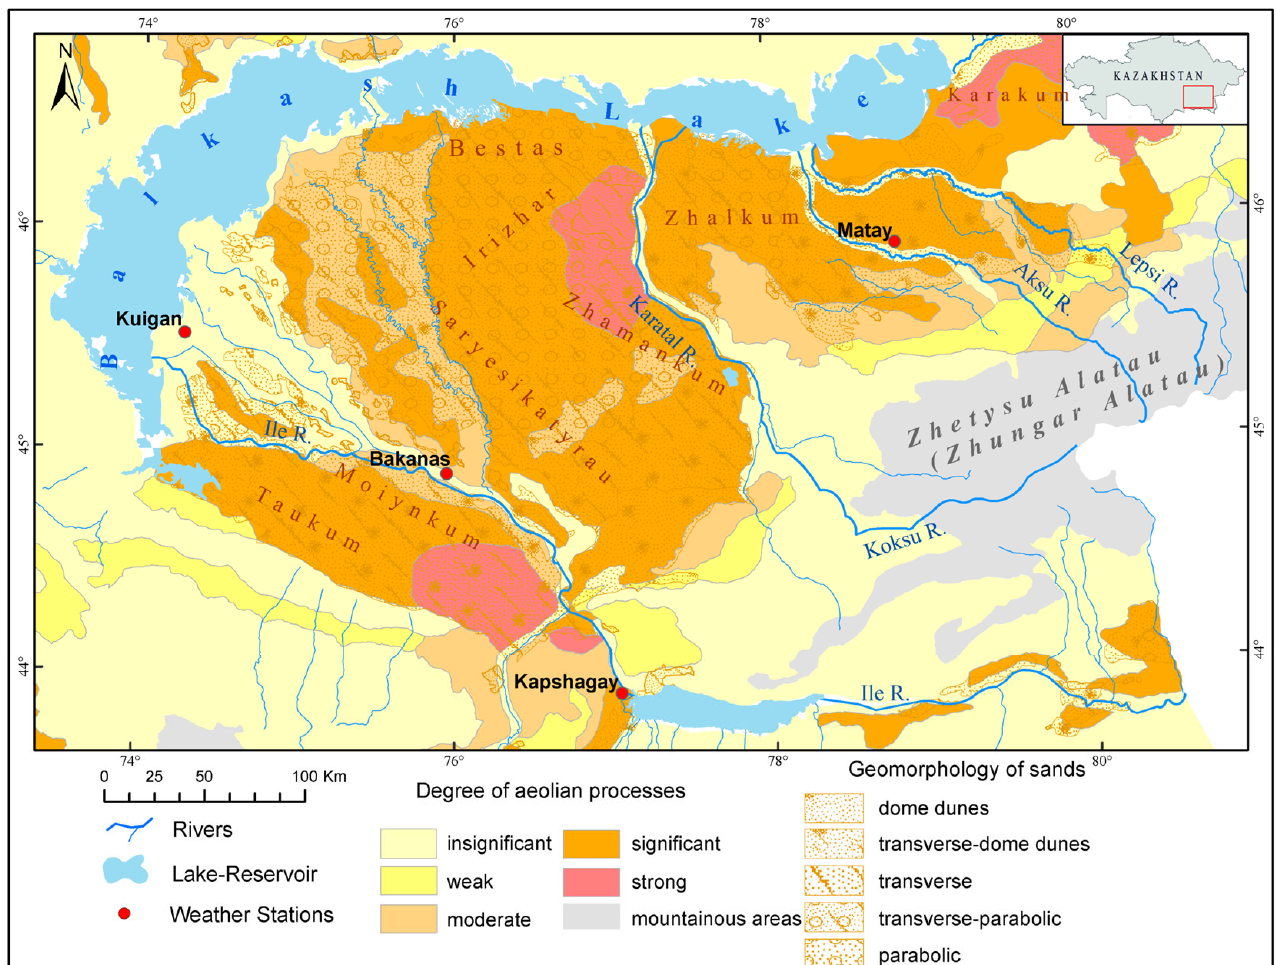
Figure 7. Regional division (zoning) of the aeolian processes in the Southern Balkash deserts.